Question: Generate an informative caption for the figure above.
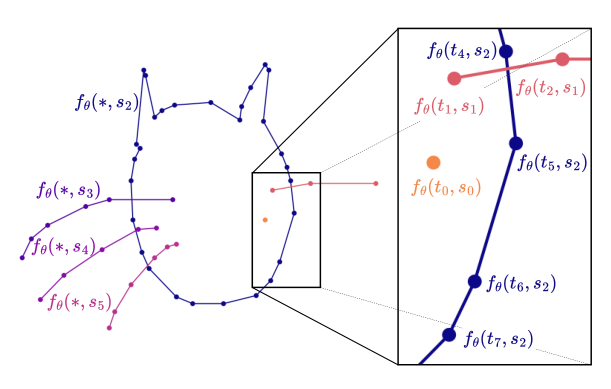
Answer: We model sketch as a function fθ(tj, sk) of J times- tamps and K strokes. Timestamps {ta, . . . , tb} where tj ∈[0, 1) correspond to way-points for a specific stroke sk. Finally, fθ with learned weights θ can be sampled with arbitrary number of strokes as tj ∈{0, 1